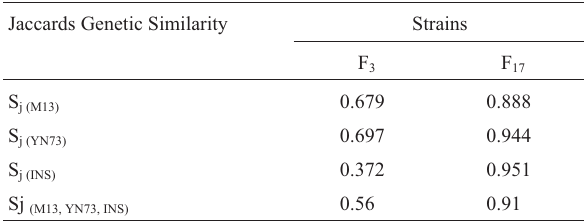
Table I - Jaccard’s genetic similarity index (Sj) for both strains of L. vannamei